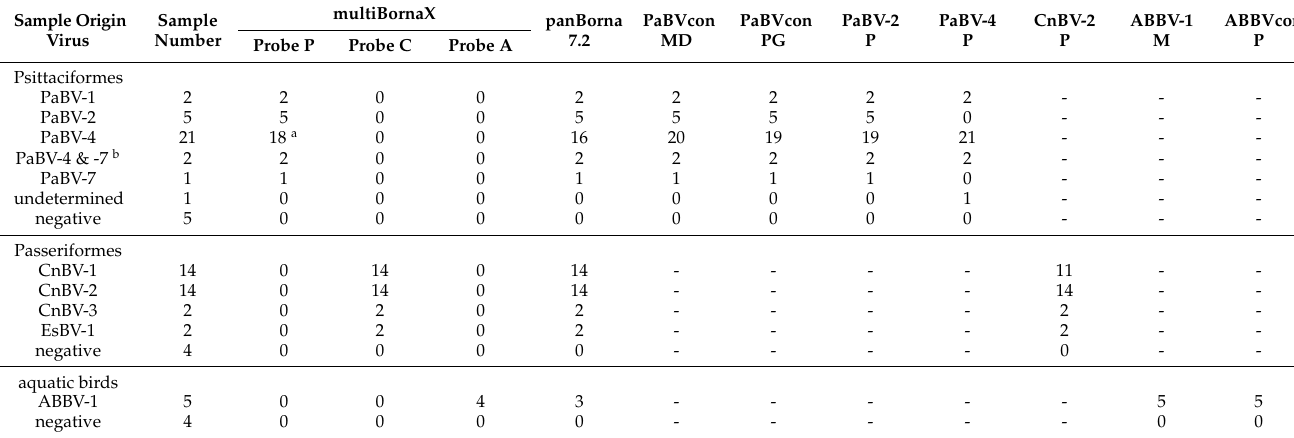
Table 4. Comparative testing of 82 clinical samples from various avian hosts with different rRT-PCR assays for the detection of avian orthobornaviruses. Total numbers of tested and positive samples are